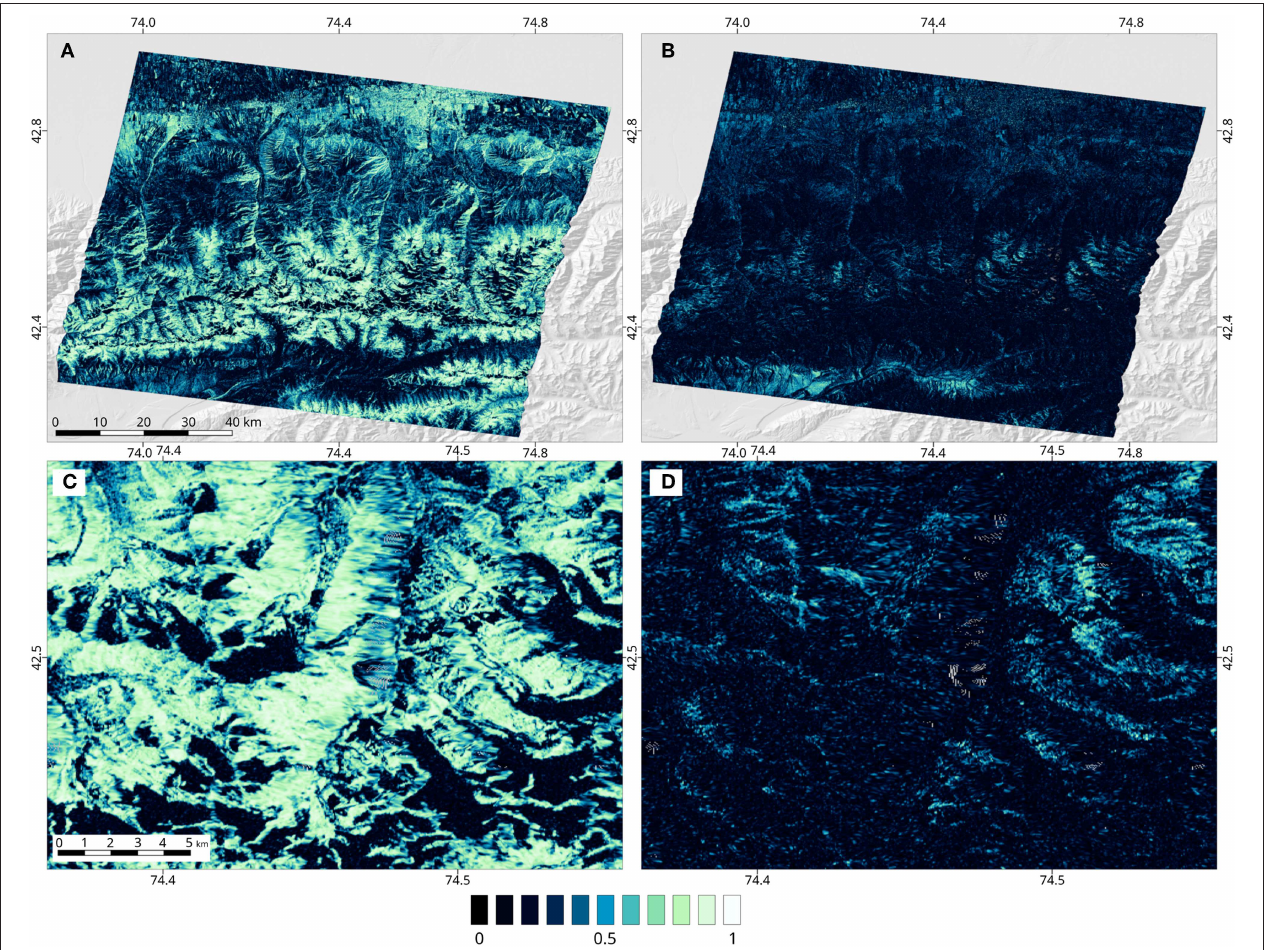
FIGURE 6 | Coherence example results for the (A,B) wider and (C,D) core study area. (A,C) Show data for the high coherence pair 2016-11-25 to 2016-12-19, (B,D) for low coherence pair 2017-07-29 to 2017-08-10. Contains modified Copernicus Sentinel data 2016,